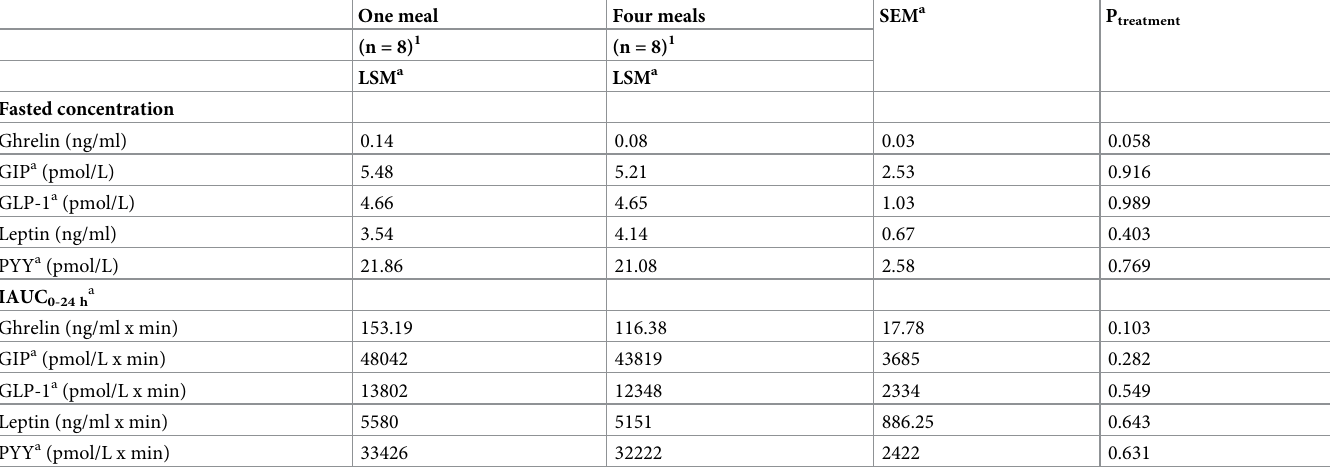
Table 3. Fasted concentration and incremental area under the curve of appetite-regulating hormones in cats eating a canned diet once (0800 h) or four (0800 h, 1130 h, 1500 h, 1830 h) times daily. One